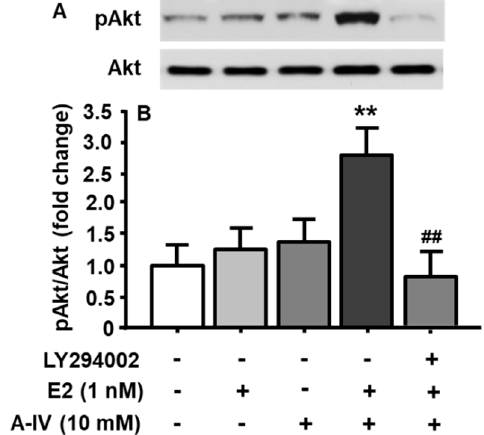
Figure 4. Combination of E2 and apoA-IV at their subthreshold doses significantly activated PI3K/Akt signaling pathway in cultured neuronal cells. Representative immunoblots of pAkt and total Akt are shown in ( A ), and quantitative analysis of the data is presented in ( B ). Mean ± S.E., n = 3. ** p < 0.01, compared to pAkt level in the cells treated with vehicles. ## p < 0.01, compared to pAkt level in the cells treated with the combination of E2 and apo